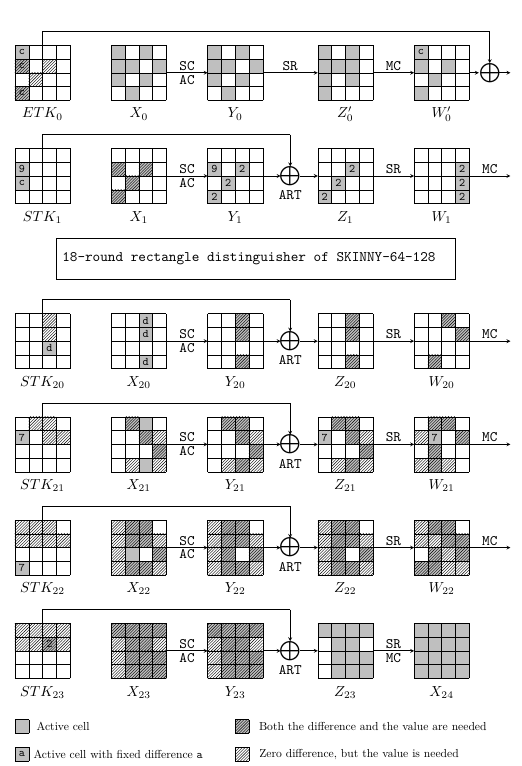
Figure 8: The 24-round attack against SKINNY-64-128